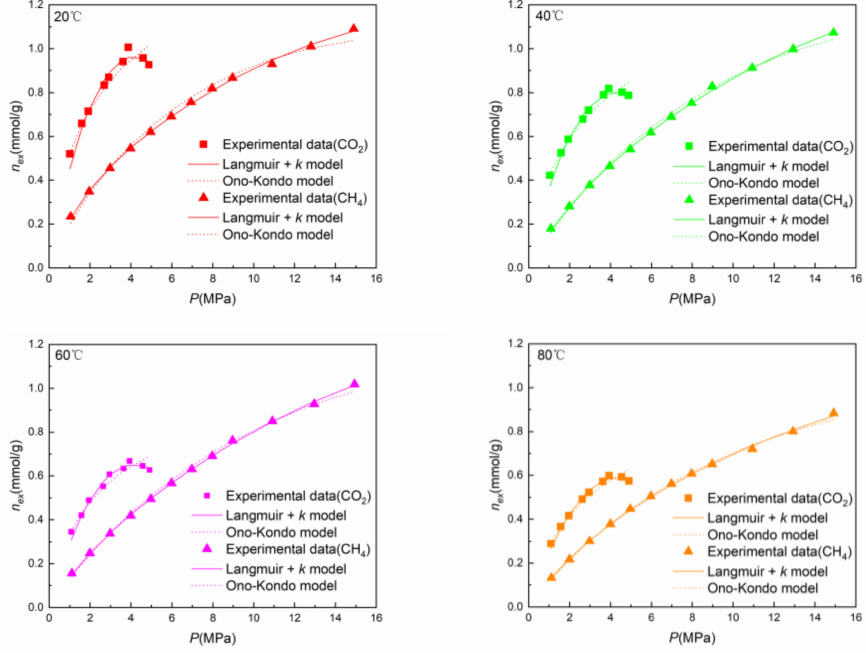
Figure 7. Comparison of adsorption isotherms between CO 2 and CH 4 at different